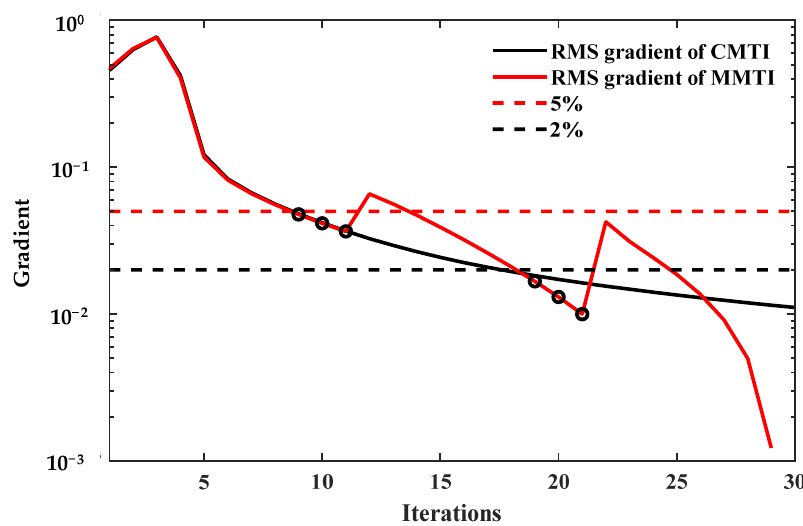
Figure 4. Multiplier-method RMS data fitting error.